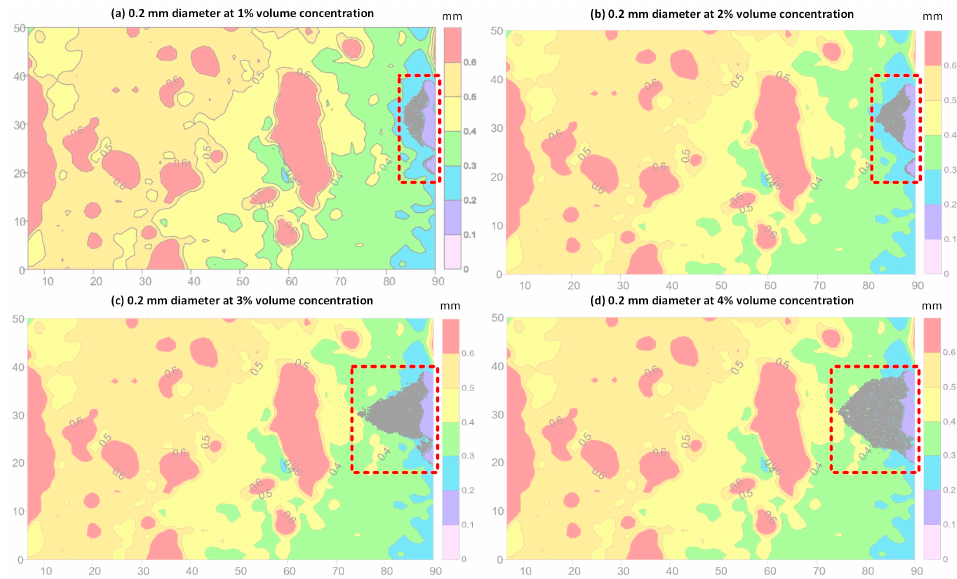
Figure 15. The distributions of plugging zone with 0.2 mm diameter LCM particles at different volume concentrations.